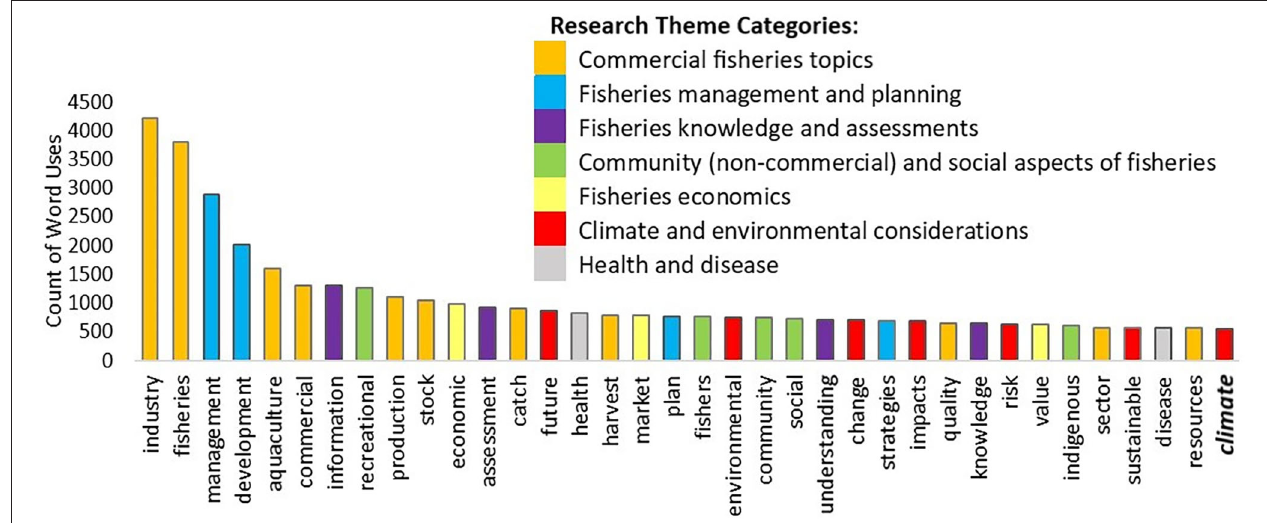
FIGURE 8 | The count of uses of the top 36 most informative keywords including and above “climate” (i.e., filler words and less informative words removed). Colors represent seven categories of similar or related research